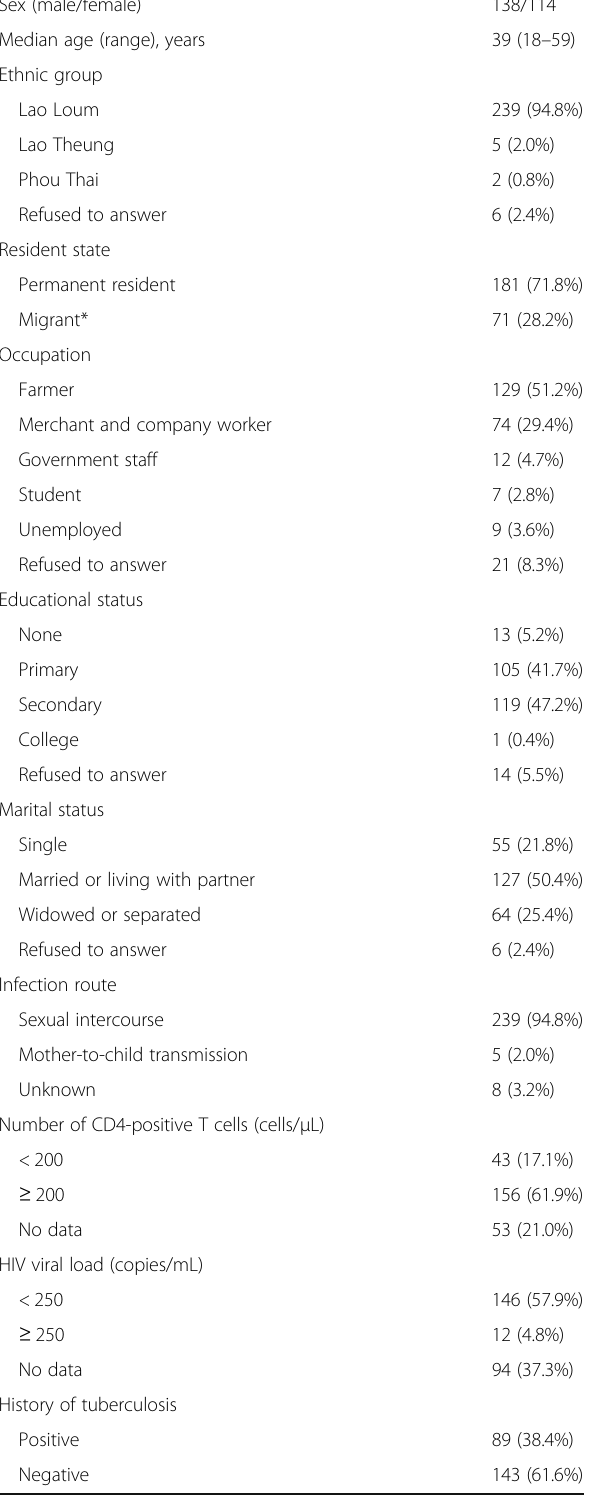
Table 1 Demographic and general characteristics of the study